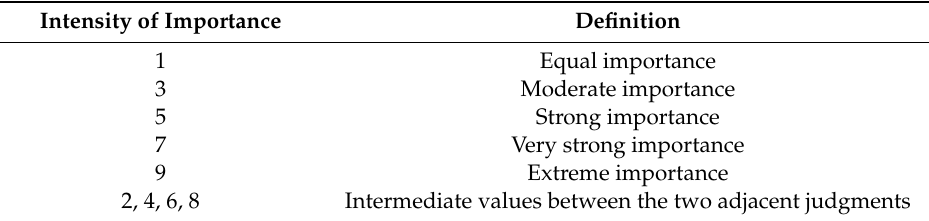
Table 2. The fundamental